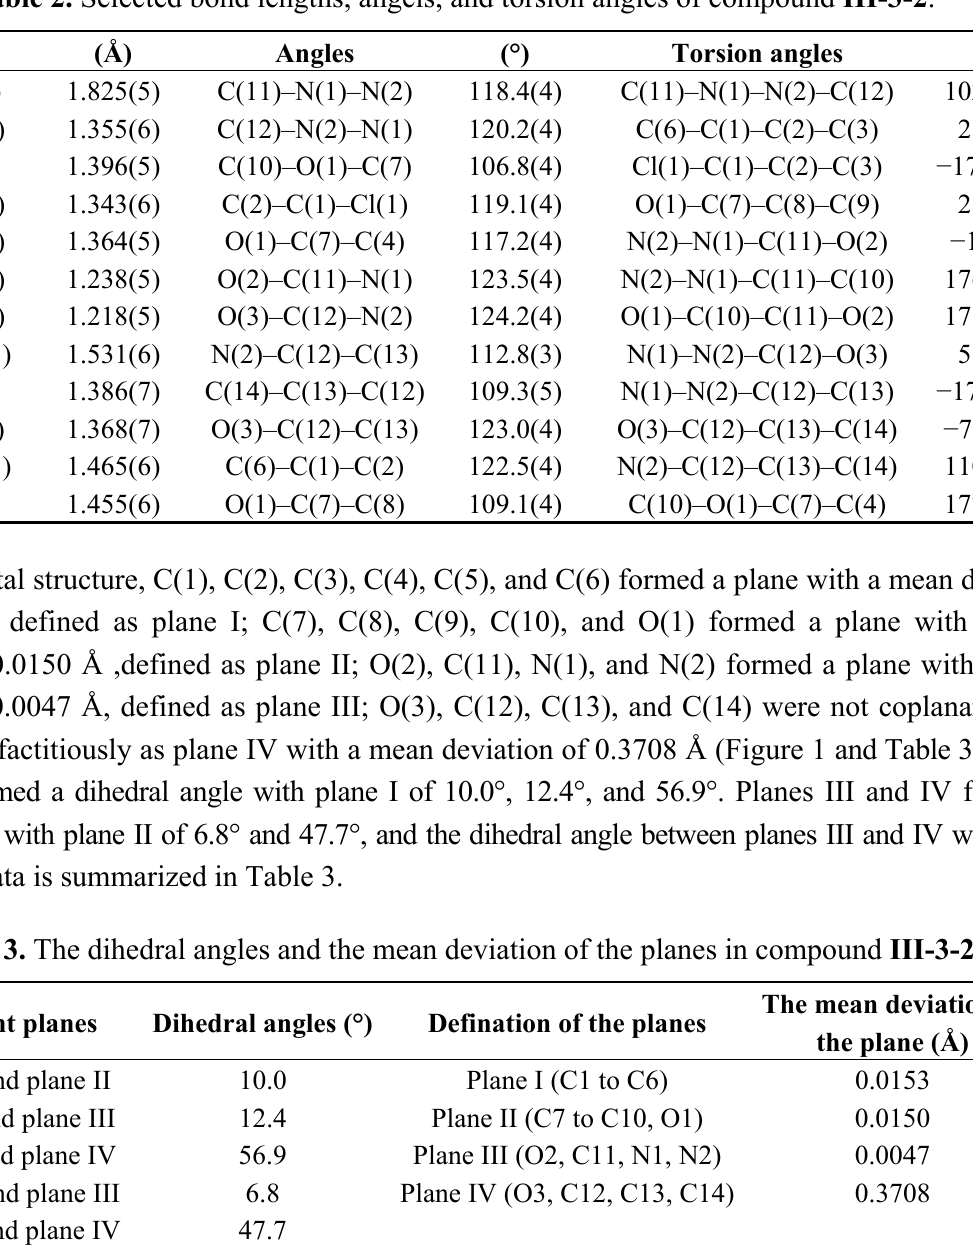
Table 2. Selected bond lengths, angels, and torsion angles of compound III-3-2